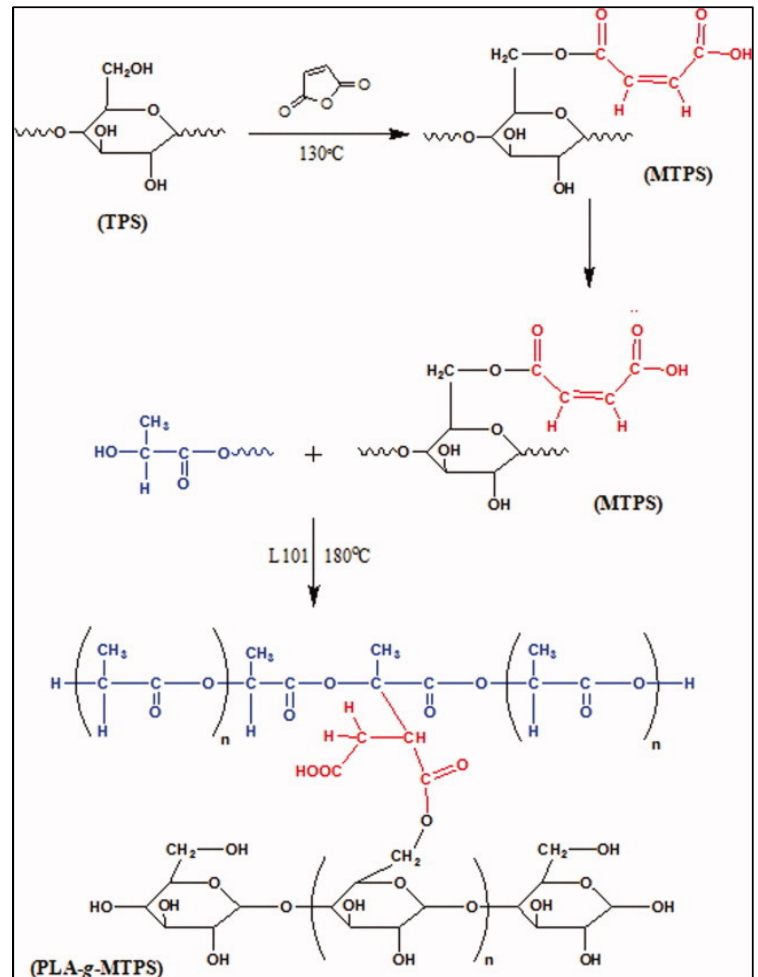
Figure 8. Reaction scheme of the MTPS formation and coupling to PLA (from Wootthikanokkhan et al. [42], copyright Wiley-VCH GmbH. Reproduced with permission).